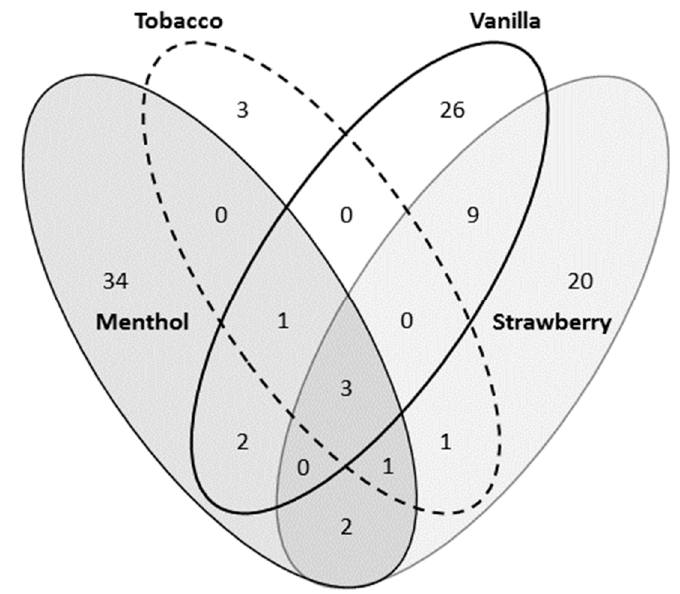
Figure 1. Flavoring composition of four popular flavored refill solutions. GCMS performed on flavored solutions identified notable overlap of flavoring chemicals present with three present in all four analyzed and an additional 16 present in two or more. Analysis also identified a wide range in the number of unique flavorings present from three in tobacco to 34 in menthol. See the Supplemental Table S1 for specific chemicals.